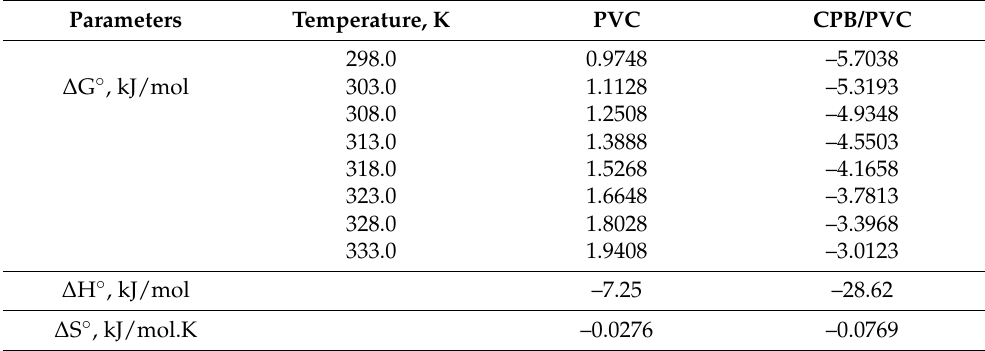
Table 4. Thermodynamic parameters of REE sorption on the PVC and CPB/PVC. Parameters